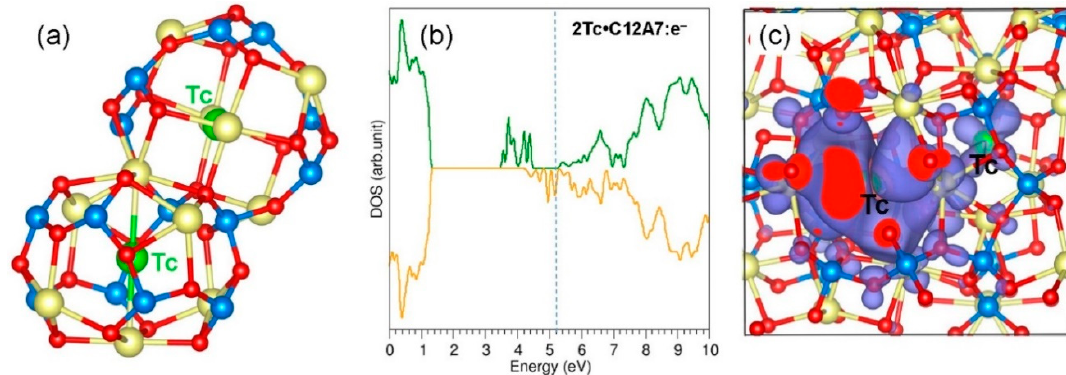
Figure 5. ( a ) Relaxed structure of two Tc atoms encapsulated in two adjacent cages in C12A7:e − ; ( b ) DOS plot calculated for 2Tc: C12A7:e − ; and ( c ) charge density plot showing the distribution of electrons in the lattice.